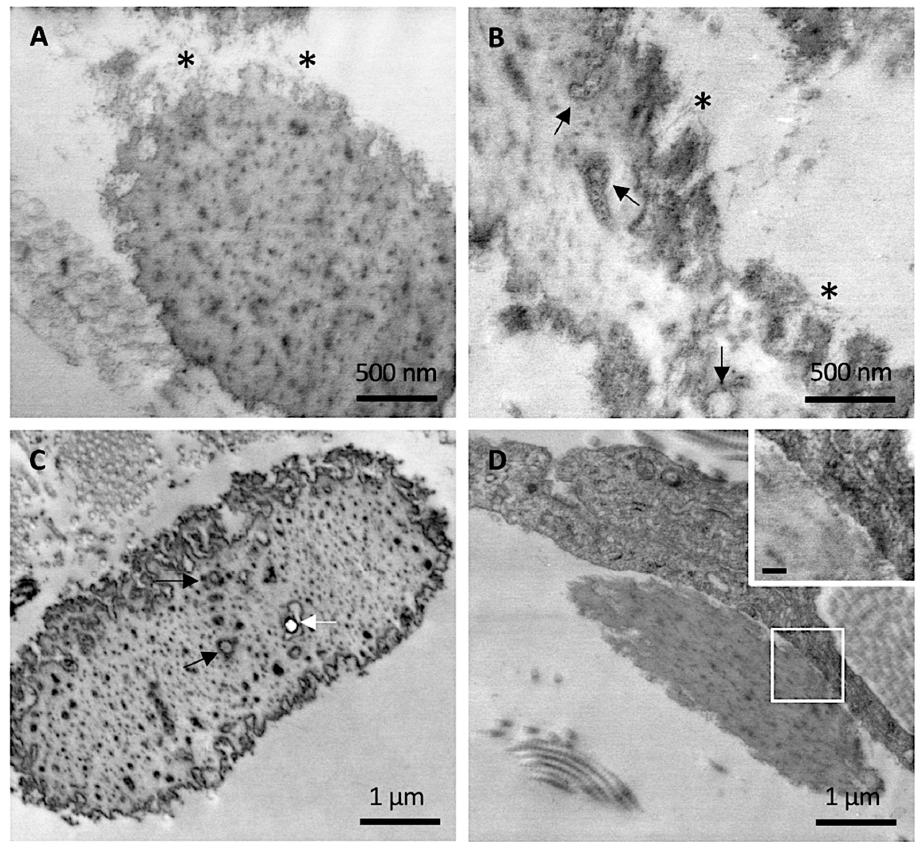
Figure 3. Representative electron microscopy images obtained from clinically unaffected skin. ( A , B ) Elastic fibers at the periphery exhibit numerous microfibrillar structures (*) whereas, in the amorphous core, round electron-translucent structures are visible (black arrows). ( C ) Round electron-translucent structures (black arrows) as well as empty holes (white arrow) are visible. ( D ) A dermal fibroblast in close contact with elastic fiber. Insert bar = 100 nm.